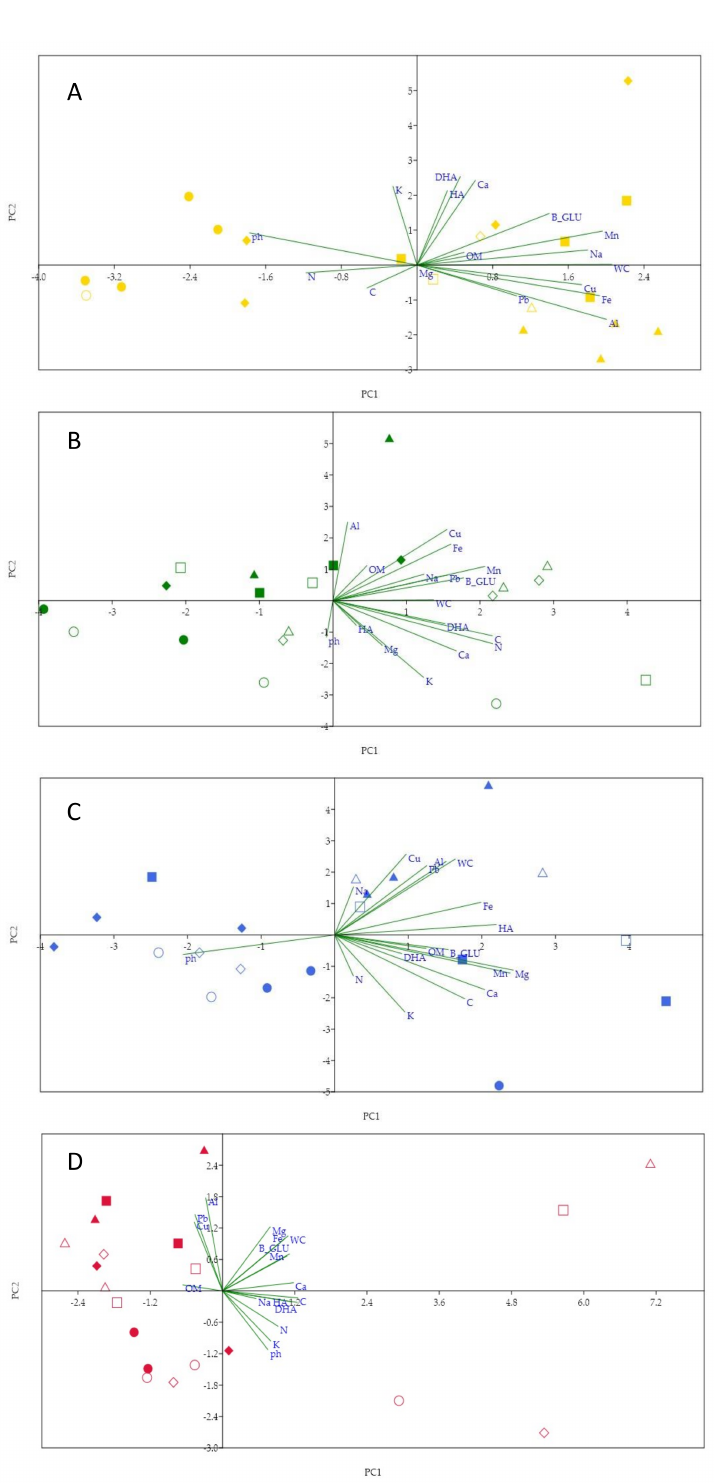
Figure 3. Graphical display of the first two axes of the Principal Component Analysis on the soil abiotic (pH; water content: WC; organic matter: OM; C and N, available fractions of Al, Ca, Cu, Fe, K, Mg, Mn, Na, and Pb) and biotic (hydrolase: HA; dehydrogenase: DHA and β -glucosidase: β -GLU) properties measured in unburnt (empty) and burnt (full) soils covered by pine (yellow in panel A ), holm oak (green in panel B ), black locust (blue in panel C ), and herbs (red in panel D ) in soils collected inside the Vesuvius National Park (Southern Italy) in summer (dot) and fall (square) 2018, and winter (triangle) and spring (rhombus)